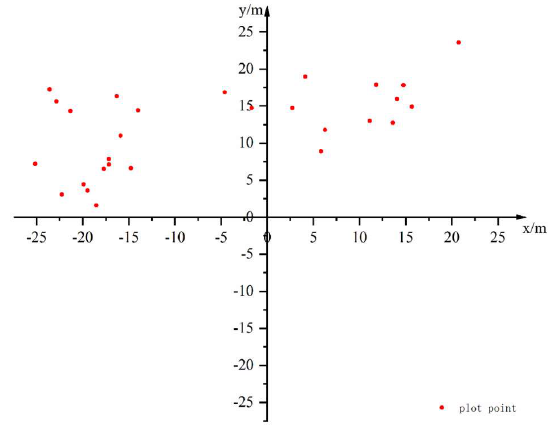
Figure 5. The error plane distribution of the precise solution results from the single-point positioning of